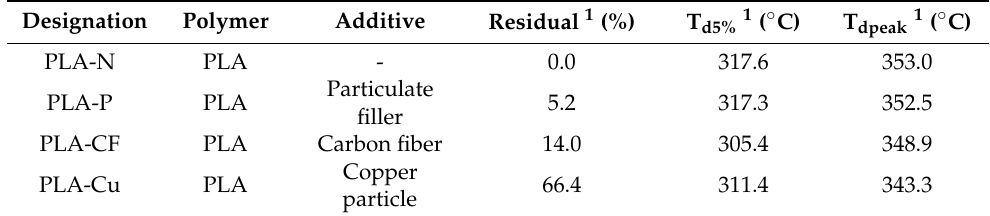
Table 1. Designation and composition of PLA filaments.